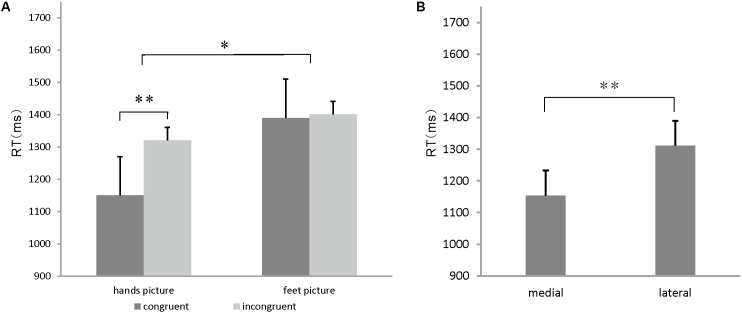
(A) Congruency effects on hands/feet stimuli. Mean reaction time (RT) for hands and feet stimuli for each congruent condition. Error bars represent the standard error of the mean. (B) In-rotation effect on hands/feet stimuli. Mean RT for stimulus judgment for each orientation condition. Error bars represent the standard error of the mean. ∗p < 0.05, ∗∗p < 0.01, ∗∗∗p < 0.001.